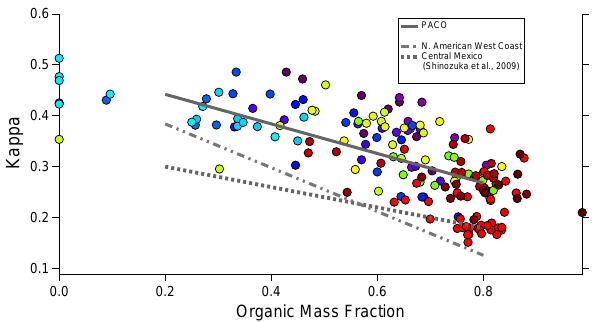
Fig. 10. κ and critical dry diameter plotted against mass fraction organic, with color scale corresponding to date; lines represent empirical parameterizations from PACO, Central Mexico, and N. American West Coast.